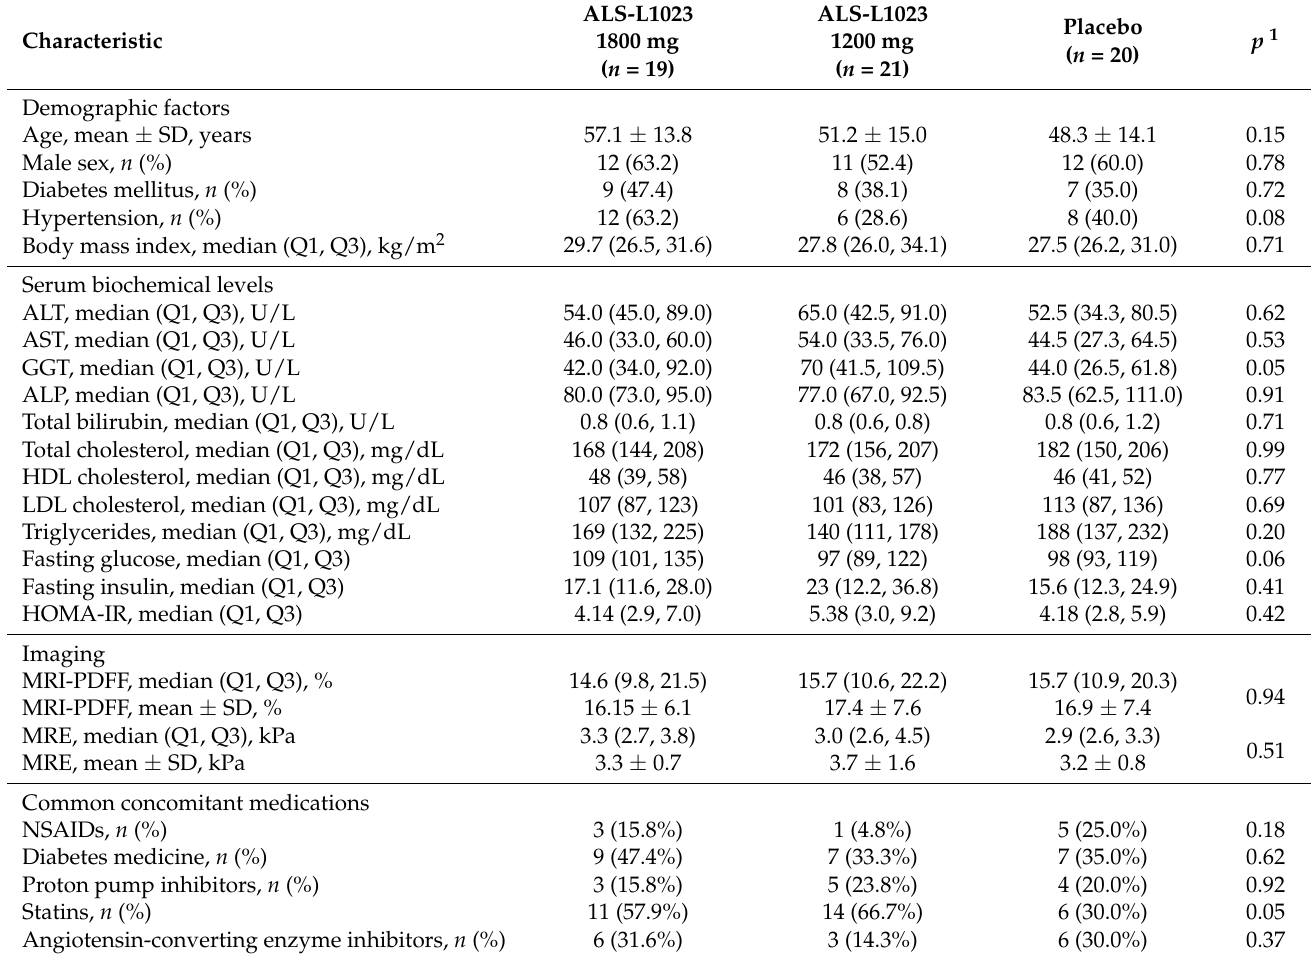
Table 1. Baseline Demographic and Clinical